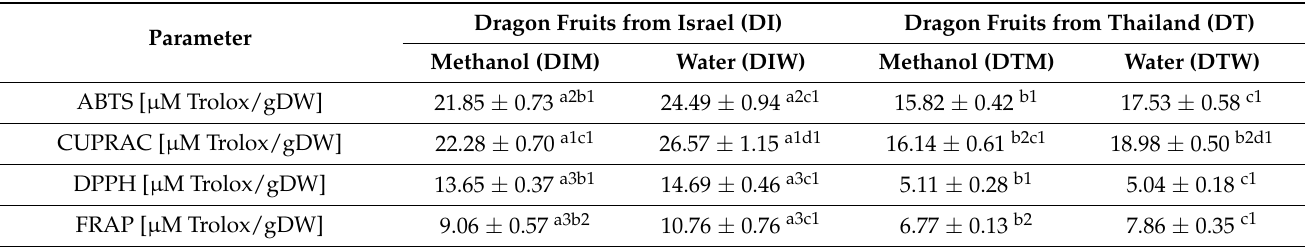
gallic acid [20]. It is in agreement with other authors [8] who suggested that antioxidant activity of dragon fruits is attributed to polyphenols. In this study, significant correlations between DPPH and two pairs of parameters (ABTS and TP; CUPRAC and FRAP), having similar weights, were observed in the partial least square model (PLS). Therefore, DPPH had high correlation weights with all these parameters, particularly with ABTS and TP (Table 3). Some data indicate that antioxidant capacities (ABTS, FRAP) of red dragon fruits were highly correlated with phenolic and flavonoid compounds, but weakly with betacyanins [21], while other authors noted that FRAP and total betacyanins showed a sig- nificant strong positive correlation (r = 0.989) and additionally ABTS and total betacyanins (r = 0.718) [22]. The results for dragon fruits antioxidant activity are consistent with those obtained for other functional fruits (durian, mango, avocado, snake fruit, mangosteen and kiwifruit) [10,23]. Table 2. Antioxidant activity of dragon fruits harvested in Israel (DI) and Thailand (DT) (mean value ± SD). Dragon Fruits from Israel (DI) Dragon Fruits from Thailand (DT) Parameter Methanol (DIM) Water (DIW) Methanol (DTM) Water (DTW) ABTS [ µ M Trolox/gDW] 21.85 ± 0.73 a2b1 CUPRAC [ µ M Trolox/gDW]